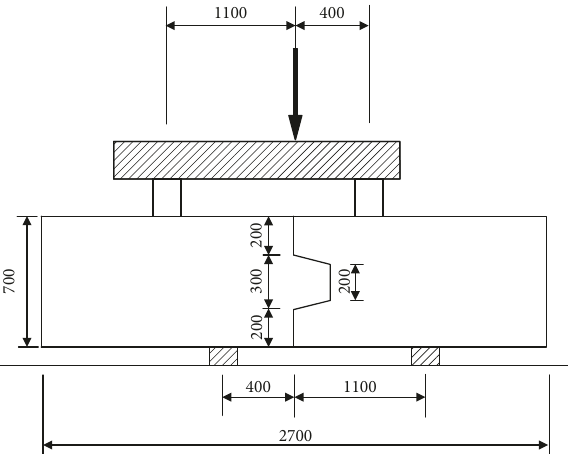
Figure 5: Sketch map of the four-point shear